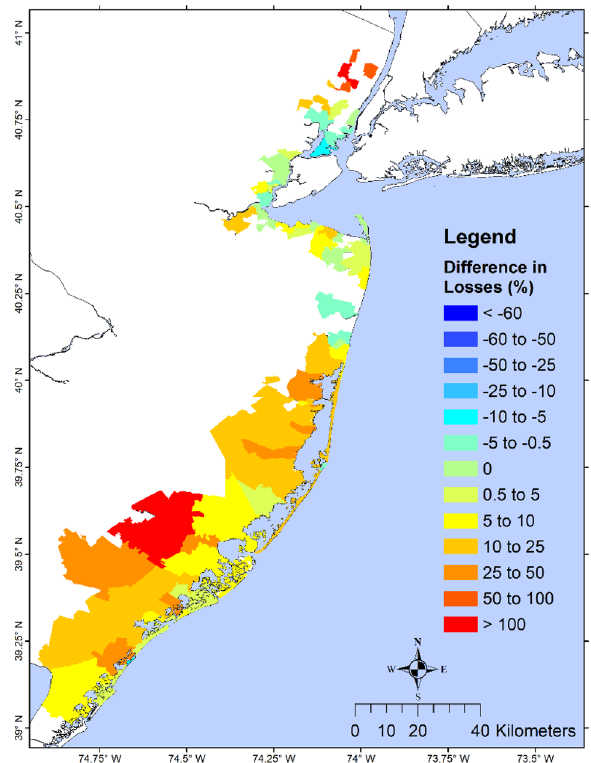
Figure 3. Percent structural loss reduction during Sandy. Map showing zip-code resolution avoided loss (difference in loss without wetlands and loss with wetlands) during Sandy, as a percentage of the loss of the with-wetland scenario. Dark red values show zip-code with the highest wetland benefit, while dark blue areas have the least benefit. Negative values indicate that the presence of wetland would increase structural losses and positive values indicate that wetland would lower the structural losses. The results are shown for the NJ coastal zip-codes affected by Sandy. This study shows that the percent avoided loss in this figure does not always represent the actual wetland value for loss reduction because areas with few structures and losses could give misleadingly high values of percent avoided loss, as shown in south NJ. The primary purpose is for comparison with a similar figure in NAR17. The map is produced using ESRI ArcGIS Pro 2.7 (https ://www.esri.com/en-us/ arcgi s/produ cts/arcgi s-pro/overv